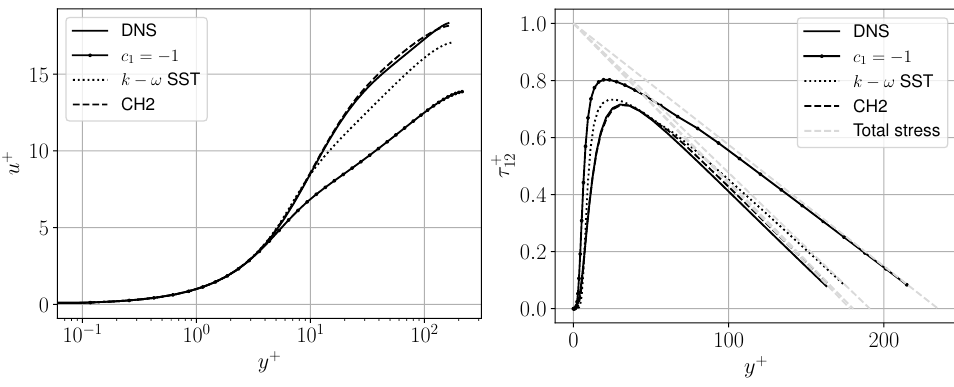
Figure 5. Channel model comparison in terms of u ( left ) and τ 12 ( right ). Table 1. Discrepancy ∆ between DNS and different models for the channel test case.